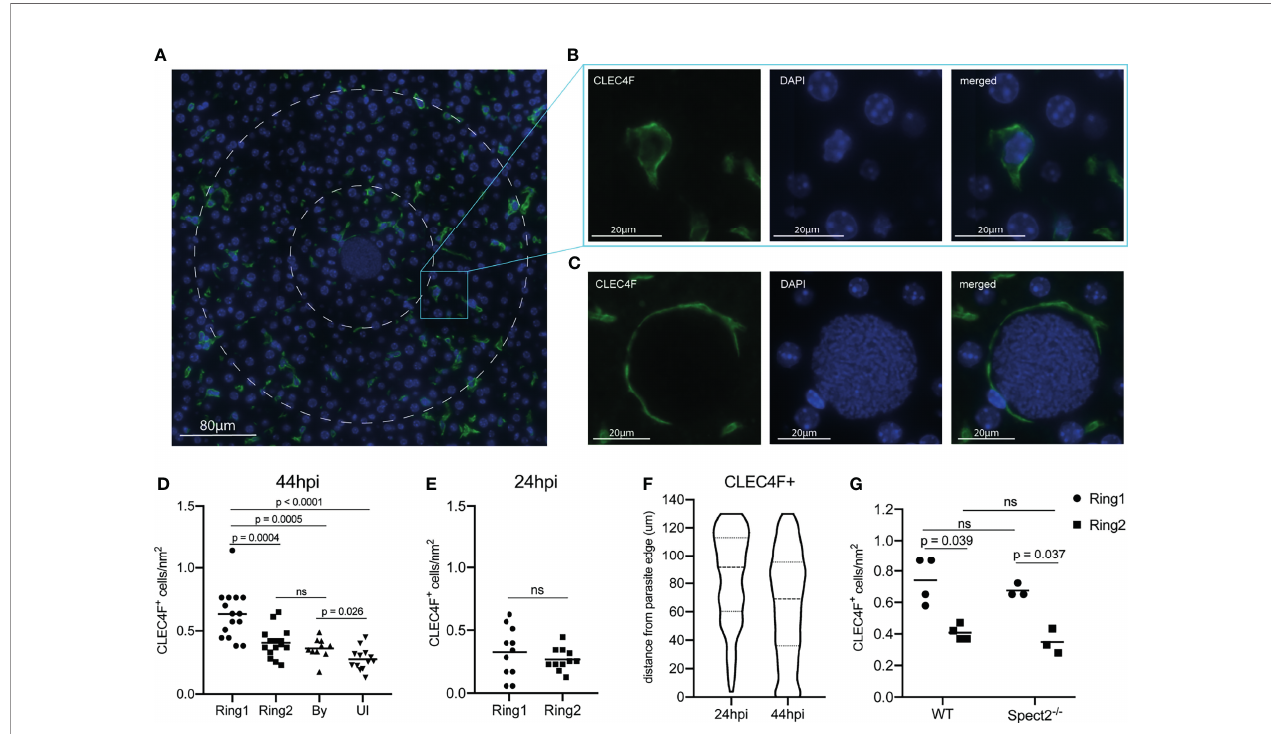
FIGURE 4 | A high density of macrophages surrounds Plasmodium infected hepatocytes. (A) Representative image of CLEC4F + staining within an infected liver. Nuclear DAPI staining is shown in blue, CLEC4F in green. Ring1 and Ring2 outer boundaries are indicated by dashed white circles. (B) CLEC4F staining of a single cell within Ring2 (C) Representative image of a CLEC4F + cell in close proximity to a parasite at 44hpi. (D) Number of CLEC4F + cells normalized by area in Ring1, Ring2, bystander (By) tissue, and uninfected (UI) tissue at 44hpi. 3-6 matched ROI sets were counted from each of three mice. (E) Number of CLEC4F + cells normalized by area in Ring1 and Ring2 at 24hpi. (F) Violin plot showing distribution of CLEC4F + cells binned by distance from parasite edge at 24 and 44hpi. (G) Levels of CLEC4F + cells in Ring1 and Ring2 around wild type (WT) and Spect2 -/- parasites at 44hpi. ns, not signi fi